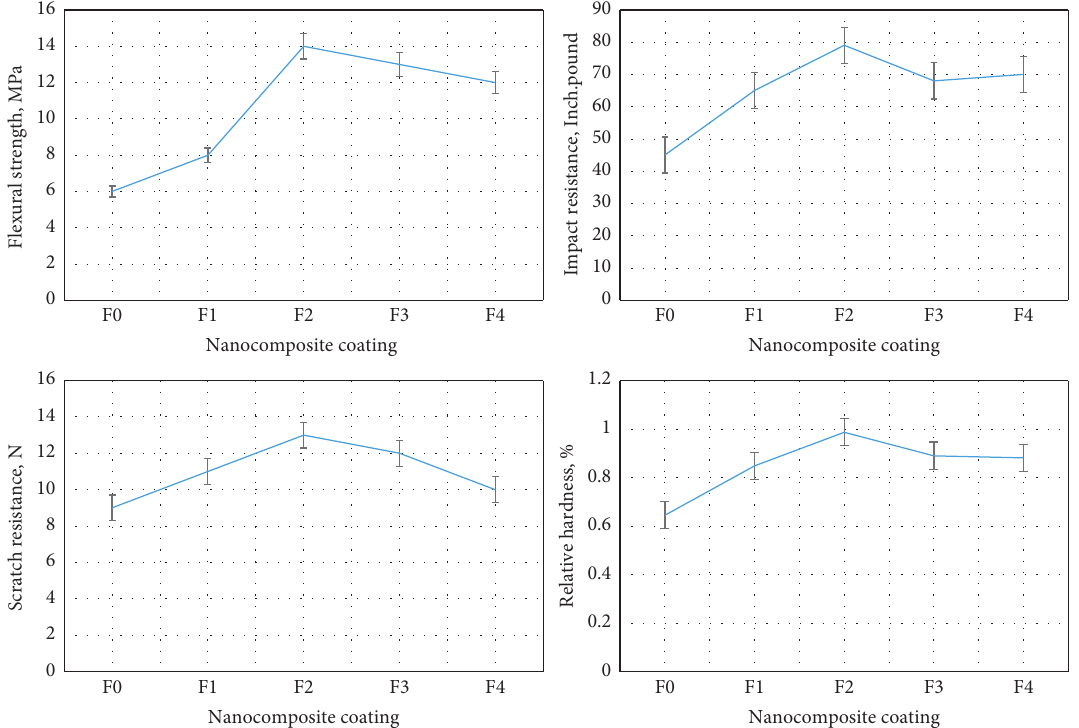
Figure 8: Mechanical properties of the nanocomposite coating.